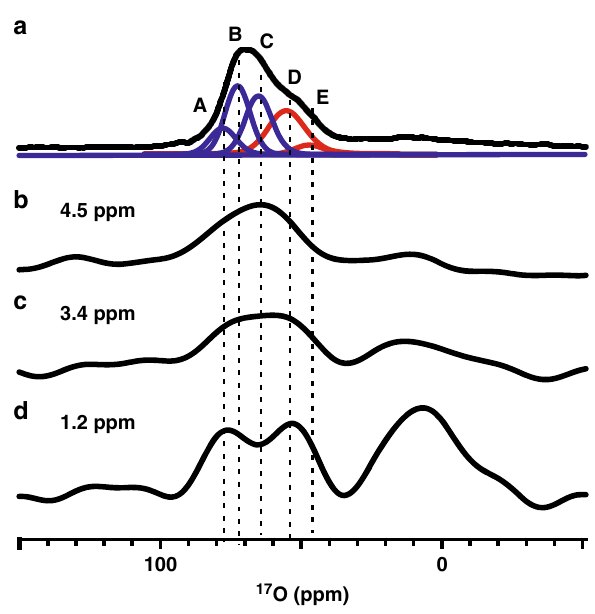
Fig. 4 Comparison of speci fi c 17 O NMR slices extracted from Fig. 3b. Deconvolution lines of 1D 17 O MAS NMR spectrum at 18.8 T ( a ), and extracted 17 O NMR slices from 4.5 ppm ( b ), 3.4 ppm ( c ) and 1.2 ppm ( d ) in the 1 H dimension of 2D 1 H{ 17 O} D-HMQC spectrum (Fig. 3b), respectively. Letters A-C denote three fi tted 4-coordinated oxygen sites (blue lines), D-E denote two fi tted 3-coordinated oxygen sites (red